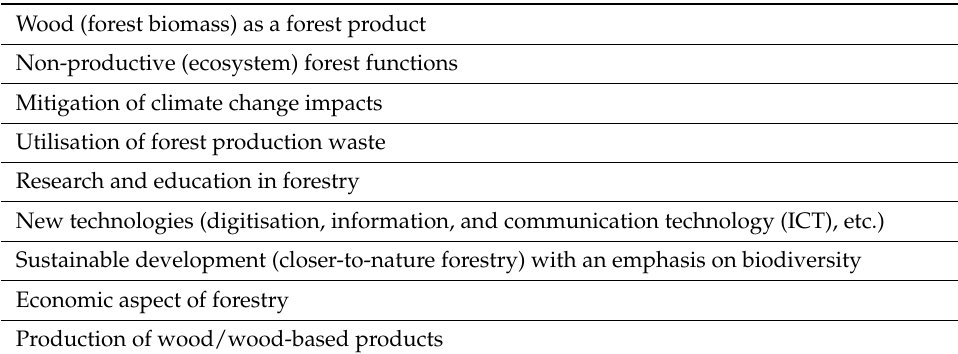
Table 1. Categories including the concept of the